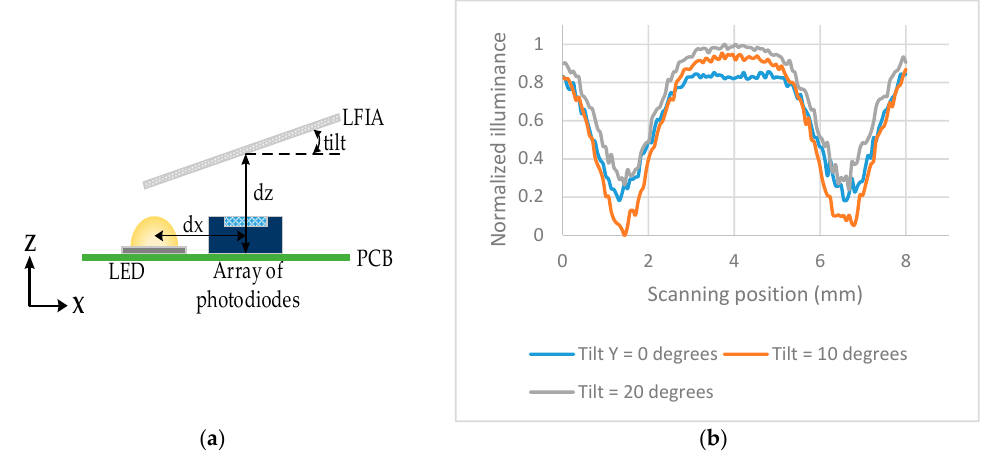
Figure 6. ( a ) Details of the tilt position, dx = 2.5 mm and dz = 2 mm; ( b ) normalized illuminance across the array of photodiodes when the strip is tilted in y -axis from 0° to 20°.